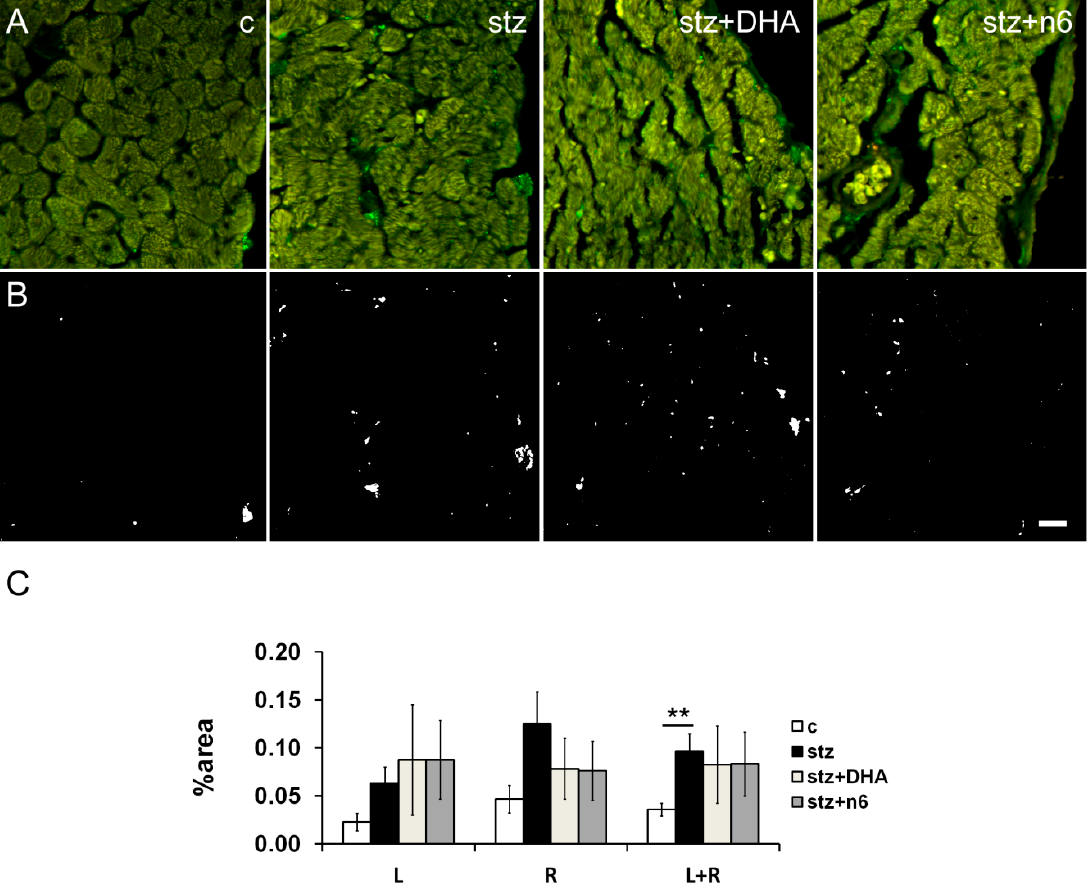
Figure 5. Tyrosine hydroxylase immunoreactive nerve fiber density in subendocardial areas of the cardiac septum. ( A ) Representative photomicrographs of right side of the subendocardial area of the cardiac septum stained for TH, a marker for sympathetic neuronal fibers (green). c—control group; stz—diabetic group fed standard diet (both diets n6 / n3 ratio ≈ 7); stz + DHA—diabetic group supplemented with n3 PUFA (2.5% of fish oil, containing 16% eicosapentaenoic acid—EPA and 19% docosahexaenoic acid—DHA; n6 / n3 ratio of ≈ 1); stz + n6—diabetic group fed with diet that contained 2.5% sunflower oil (n6 / n3 ratio ≈ 60). ( B ) Threshold figures from A; white—nerve fiber